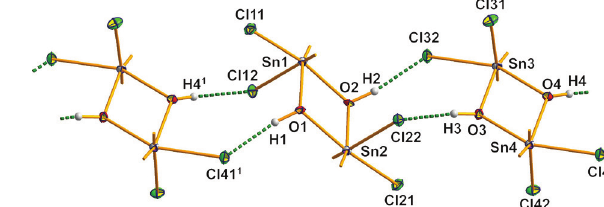
Figure 2 Ball-and-stick model of the hydrogen bonding system in the crystal structure of 1 ⋅ DMF . Isobutyl groups and DMF molecules are omitted for clarity, -OH Cl hydrogen bonds are indicated by green broken sticks; symmetry code: (1) x, y , −1+ z